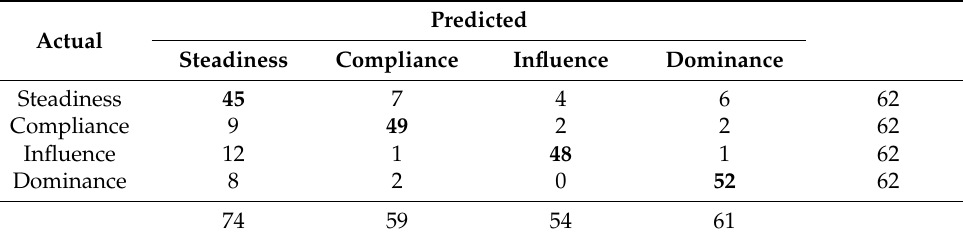
Table 13. Confusion matrix for AdaBoost classifier with DS4.